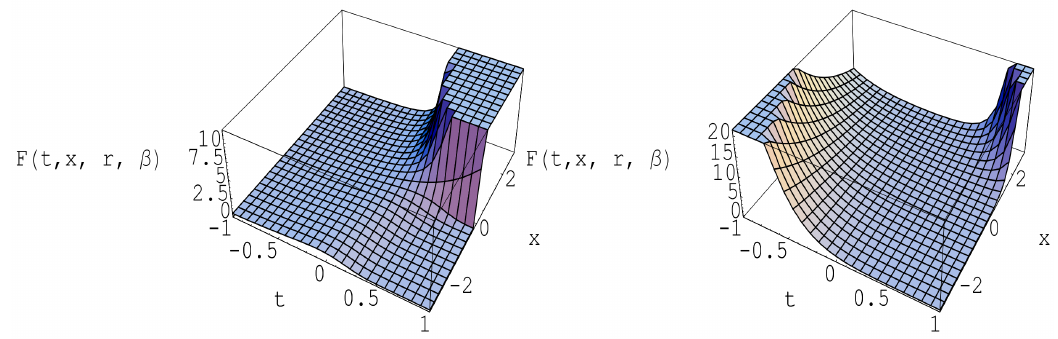
Figure 1. The surface for the solution F ( t , x , r , β )